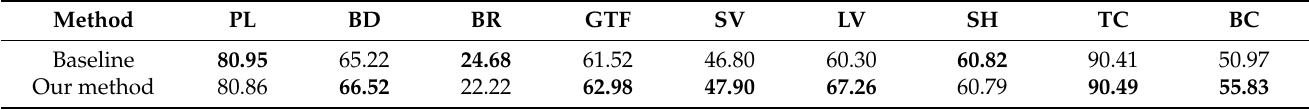
Table 2. Detection accuracy (Ap for each category and overall mAP) on different objects in DOTA. The short names for categories are defined as PL—PLANE, BD—BASEBALL DIAMOND, BR—BRIDGE, GTF—GROUND FIELD TRACK, SV—SMALL VEHICLE, LV—LARGE VEHICLE, SH—SHIP, TC— TENNIS COURT, BC—BASKETBALL COURT.